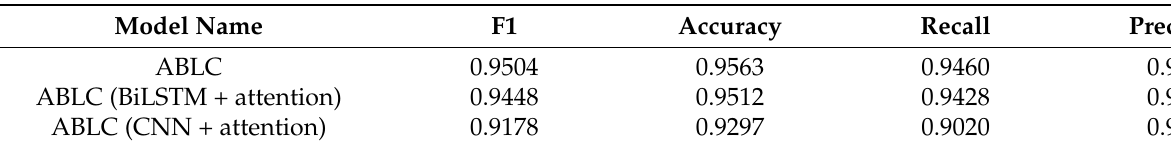
Table 6. Experiment results on ablation analysis.